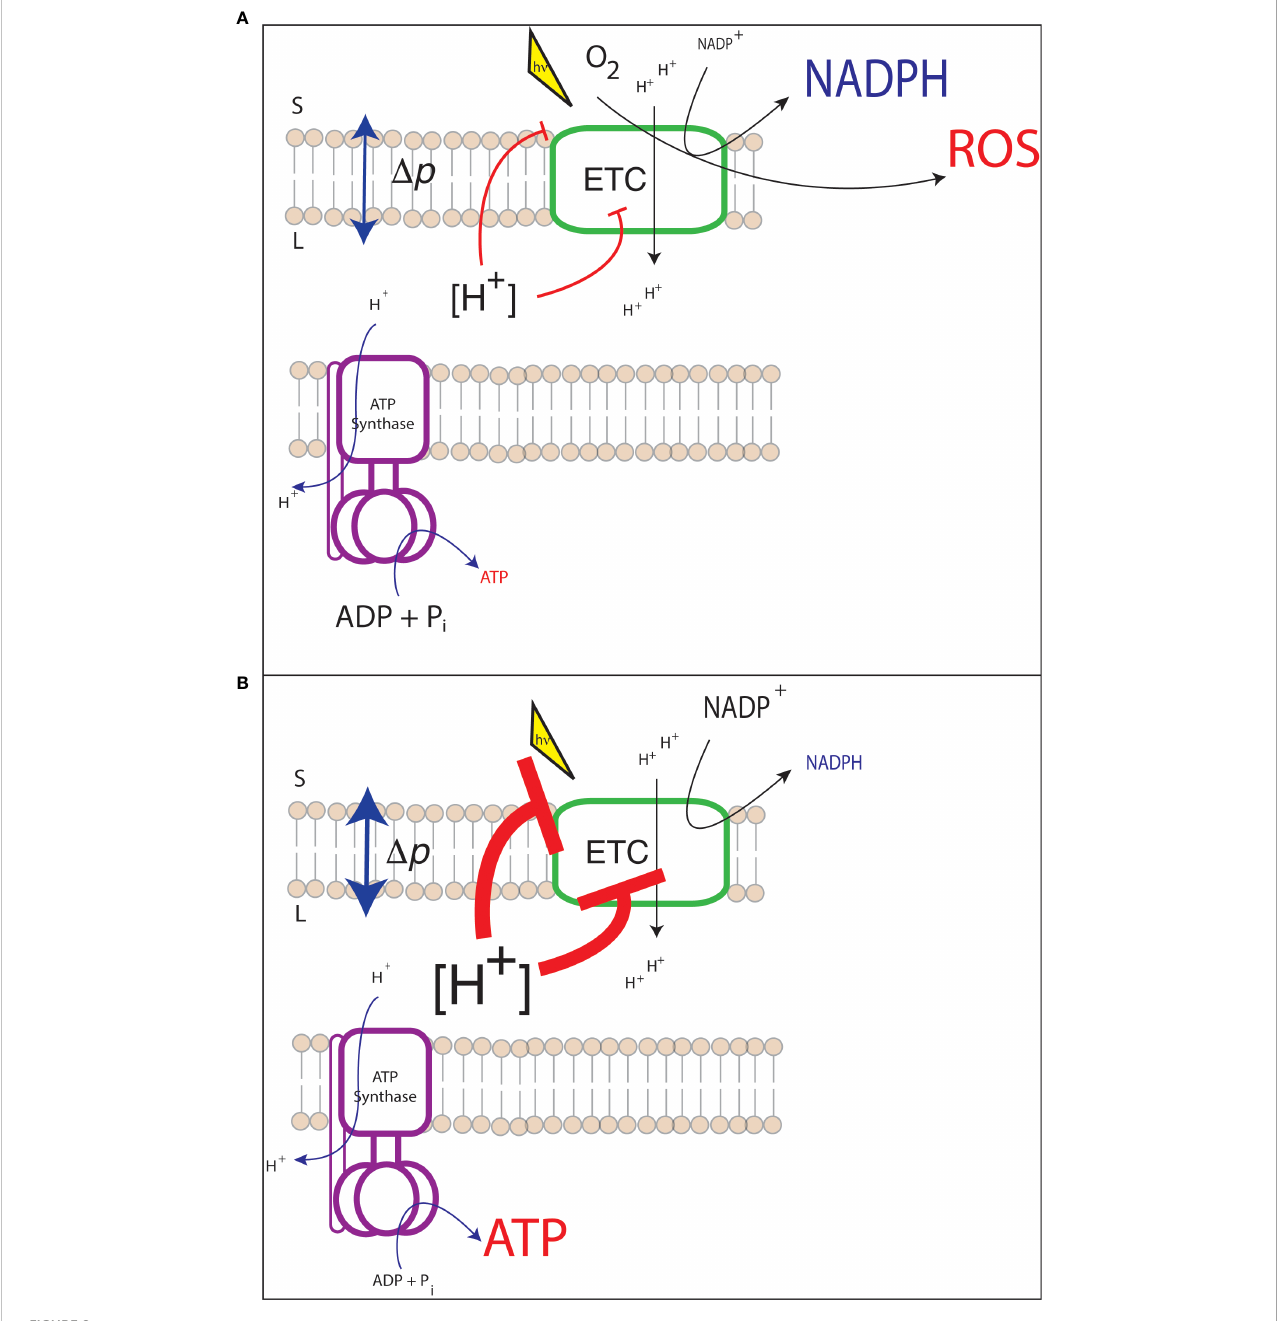
FIGURE 2 Possible consequences of energetic mismatch between the electron transport chain (ETC) and downstream metabolism. (A) An ATP de fi cit may result in the closure of the acceptor side of PSI and the generation of harmful reactive oxygen species (ROS); (B) An ATP surplus may lead to substrate limitation of ATP synthase and the downregulation of light harvesting and electron transfer resulting in lower photosynthetic ef fi